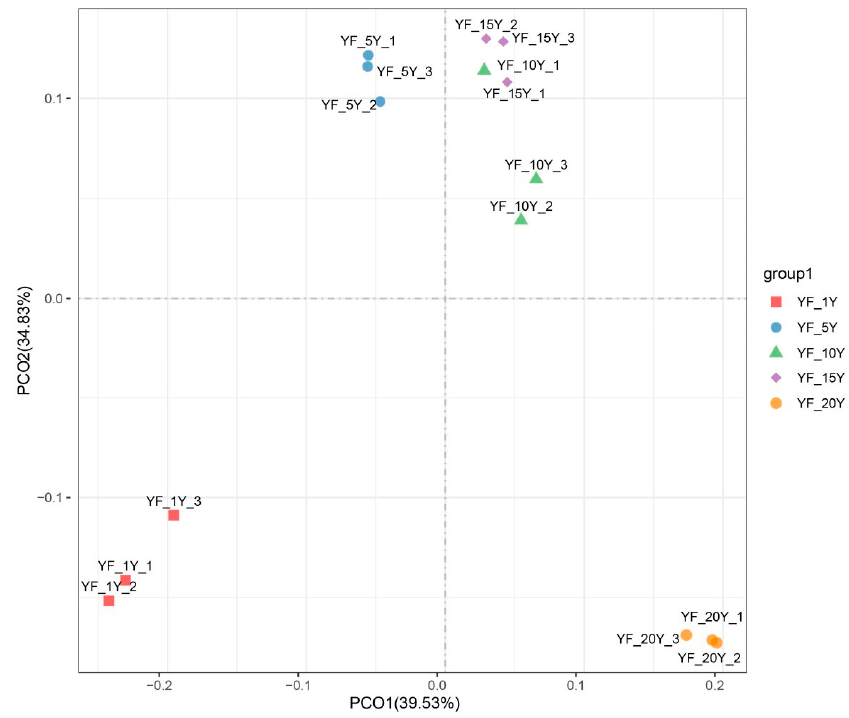
Figure 2. PCoA of bacterial communities in different rhizospheric soil samples based on weighted_unifrac distances.